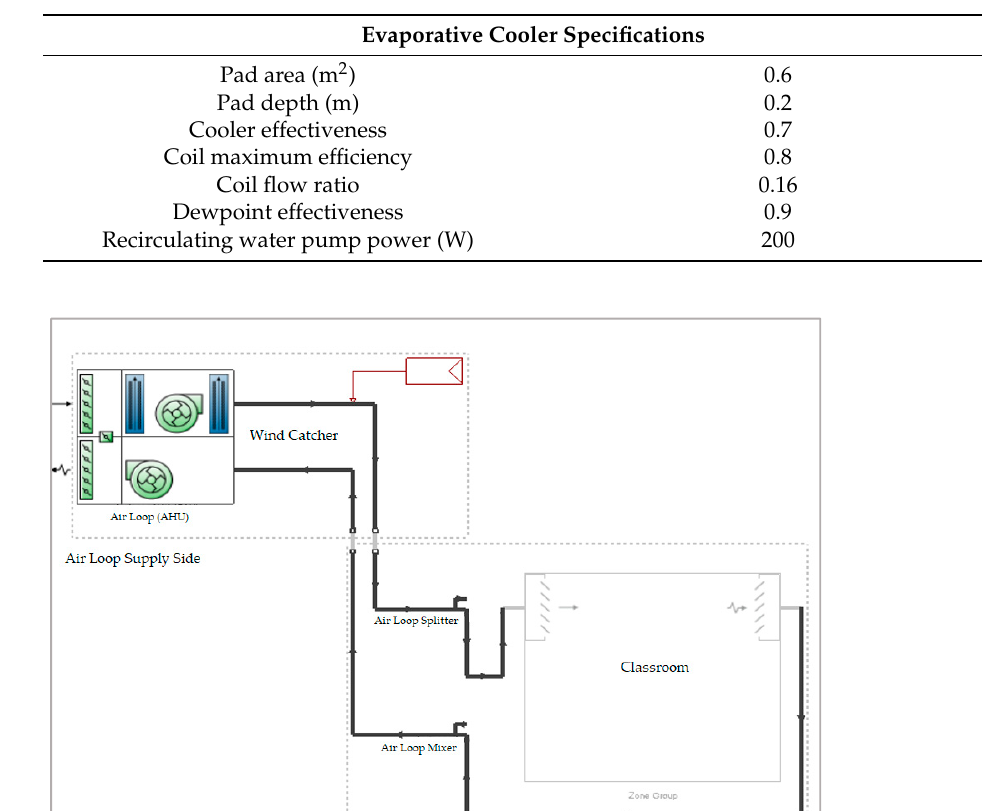
Figure 9. HVAC design in DesignBuilder V5.4 for the wind catcher plus evaporative cooler inte- grated with the